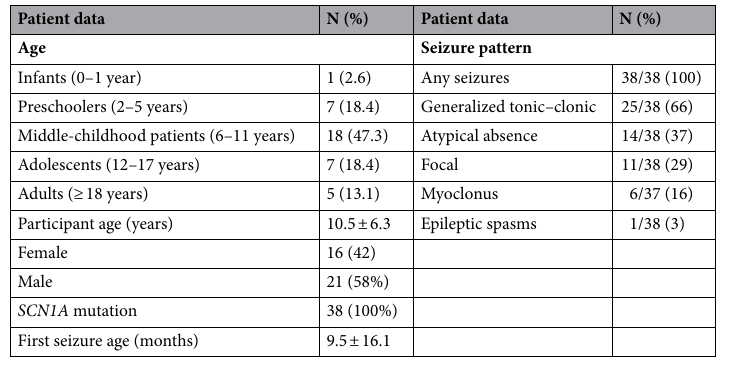
Table 1. Demographics data of 38 patients with DS. Data are presented as mean ±